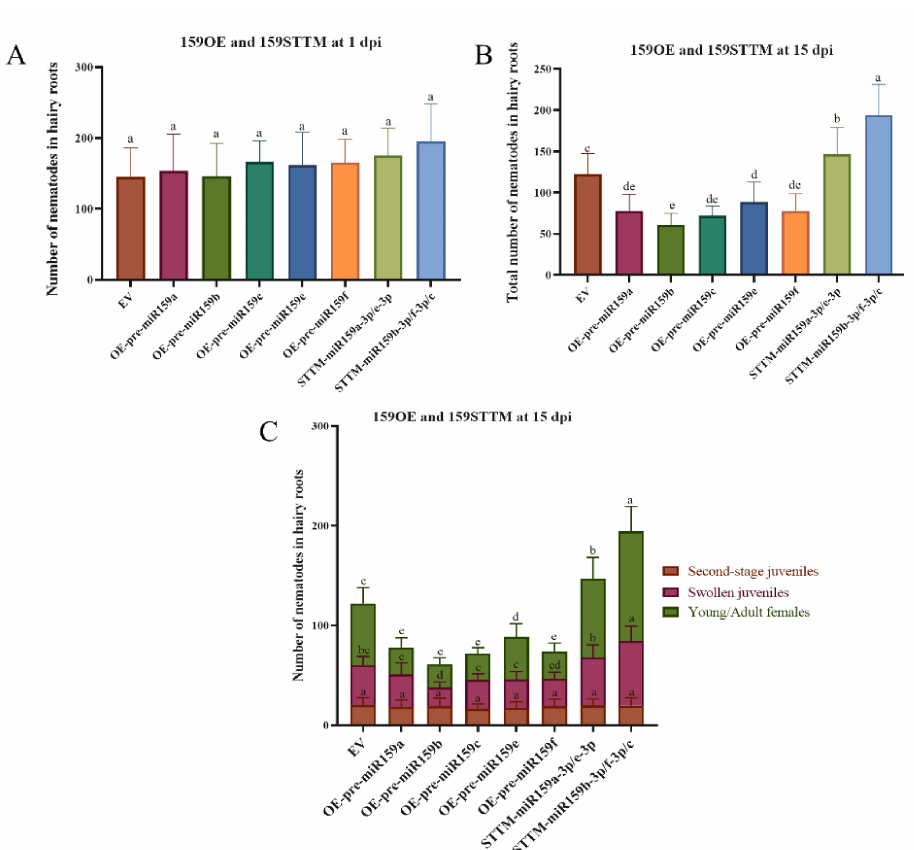
Figure 6. Penetration and development of soybean cyst nematode in transgenic hairy roots. ( A ) Number of second-stage juveniles in hairy roots examined at 1 dpi. ( B ) Total number of ne- matodes in hairy roots at 15 dpi. ( C ) Number of different stages nematodes in the soybean hairy roots. EV, empty vector; OE-pre-miR159, miR159 overexpressing soybean hairy roots; STTM-miR159, soybean hairy roots of short tandem target mimic (STTM) of miR159. dpi, day post inoculation. Multiple statistical comparisons between nematodes in EV and other transgenic hairy roots were made by one-way analysis of variance (ANOVA) followed by LSD post hoc test. Different characters mean significant differences found at p < 0.05 level. ns, not significant. Error bars represent standard deviation from the